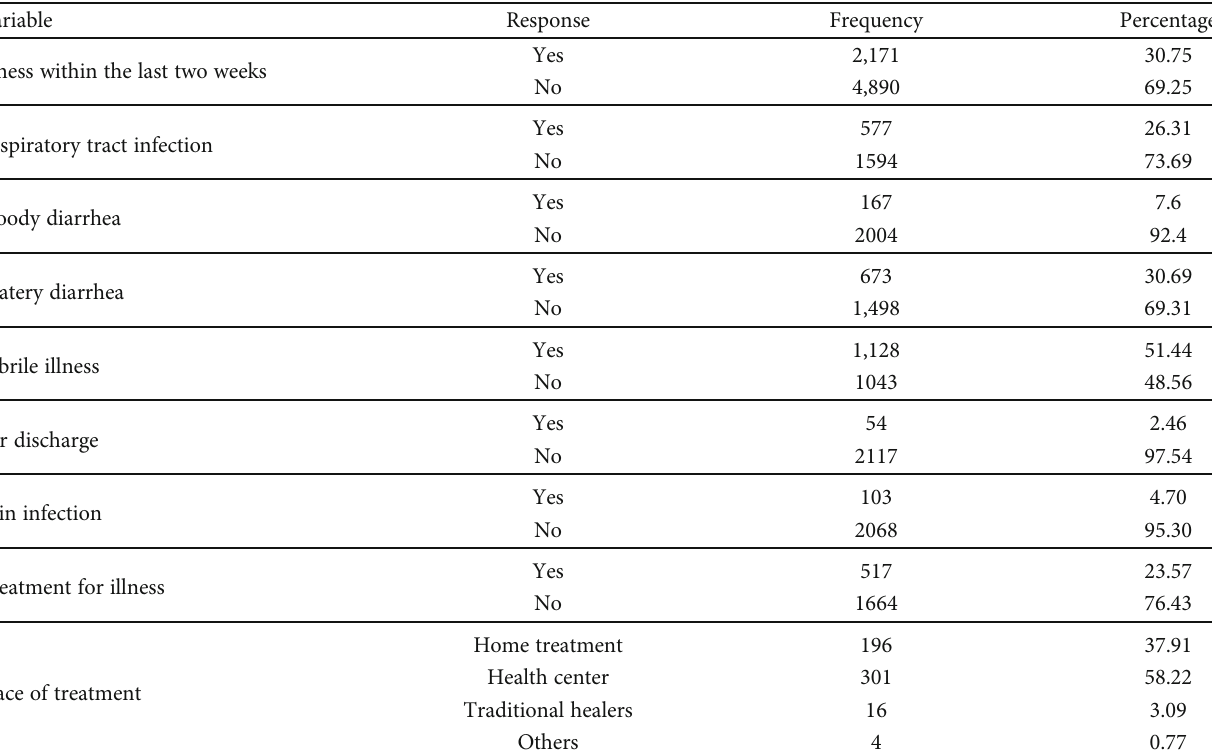
Table 3: Child hood health problems in Dabat HDSS site, Dabat district, North West Ethiopia: August